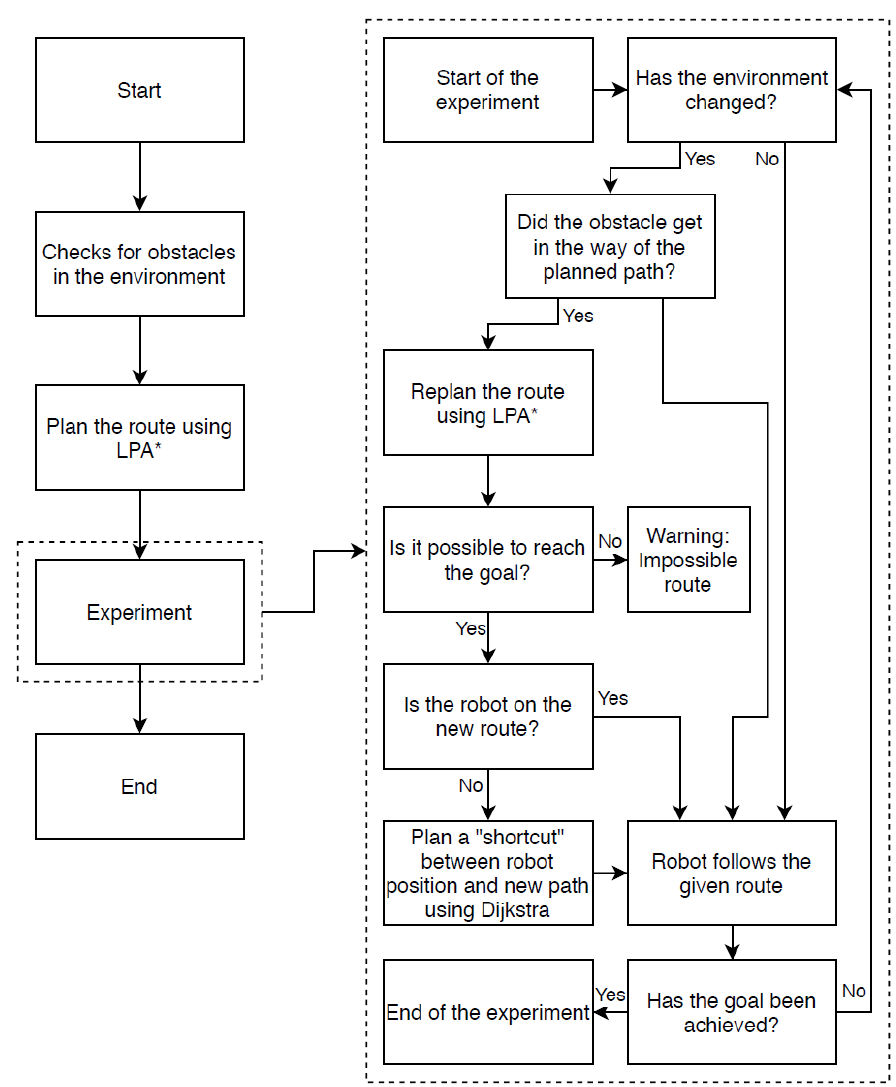
Figure 1. The route planning strategy flowchart for a mobile